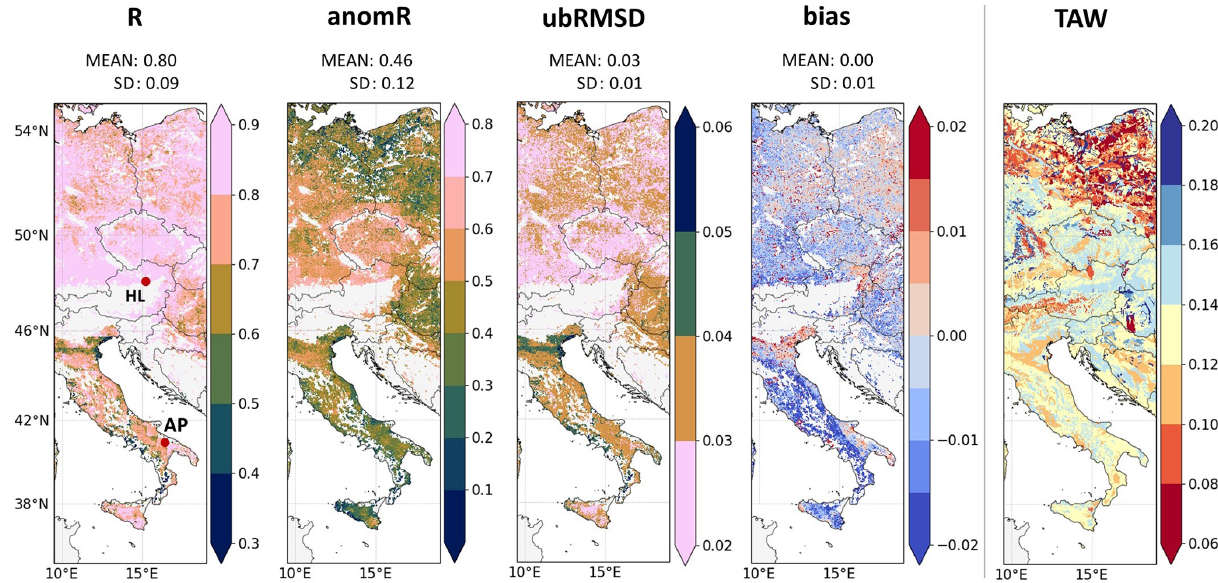
Figure 3. Temporal metrics of AquaCrop biomass evaluated against CGLS-DMP, with metrics R (–), anomR (–), bias (tha − 1 d − 1 ), and ubRMSD (thad − 1 ). The spatial mean and standard deviation of the metrics are indicated with MEAN and SD. Also shown is the TAW (m 3 m − 3 ) computed as the field capacity minus wilting point, without taking rooting depth into account. Light grey areas represent no data.